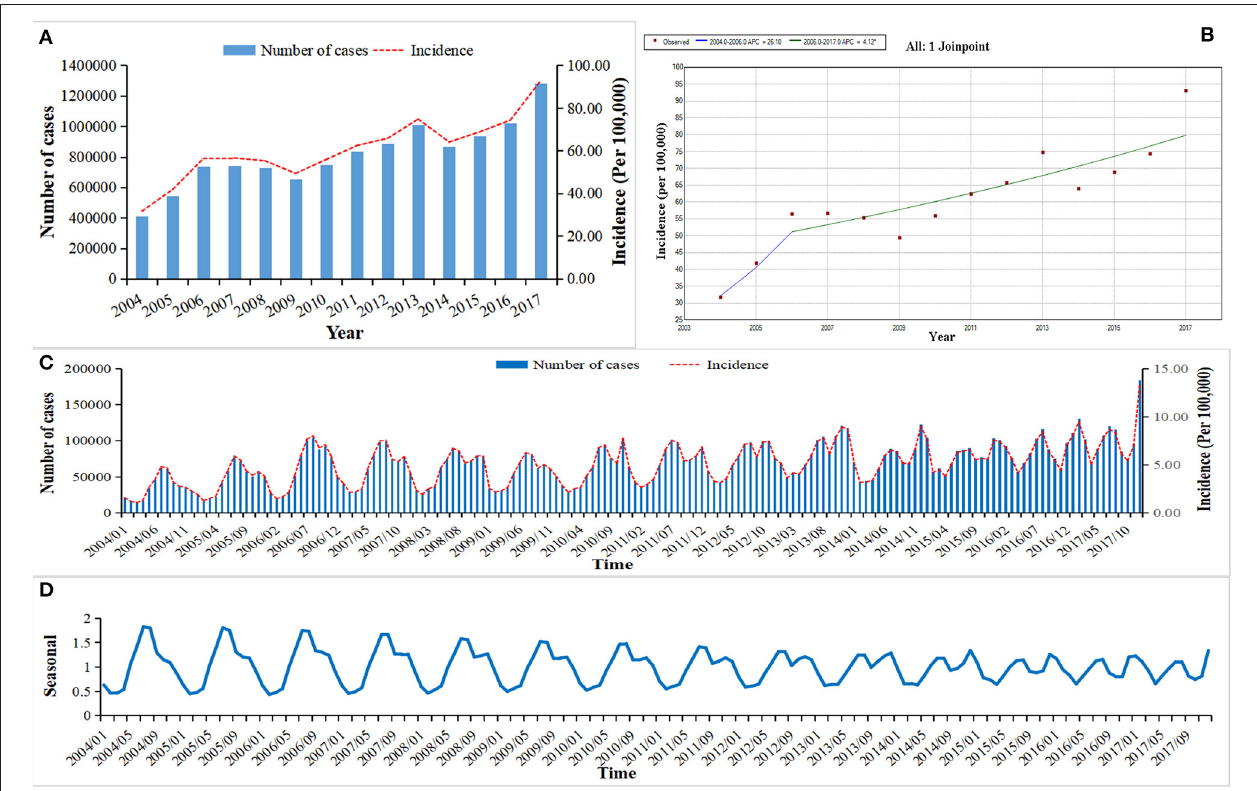
FIGURE 1 | The incidence and trend of other infectious diarrhea in mainland China from 2004 to 2017. (A) The annual incidence of OID from 2004 to 2017. (B) The Joinpoint analysis of OID from 2004 to 2017. (C) The monthly incidence of OID from 2004 to 2017. (D) Seasonal decomposition analysis of OID from 2004 to